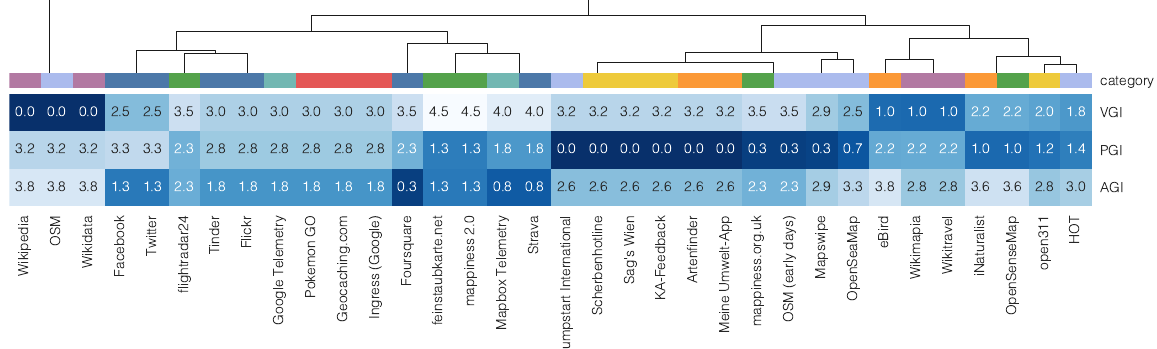
Figure 10. Hierarchical clustering of Geographical Shared Data Sources (GSDSs) by similarity to prototypes, only considering dimensions related to the organizer, using the cosine similarity. The legend for the categories can be found in Figure